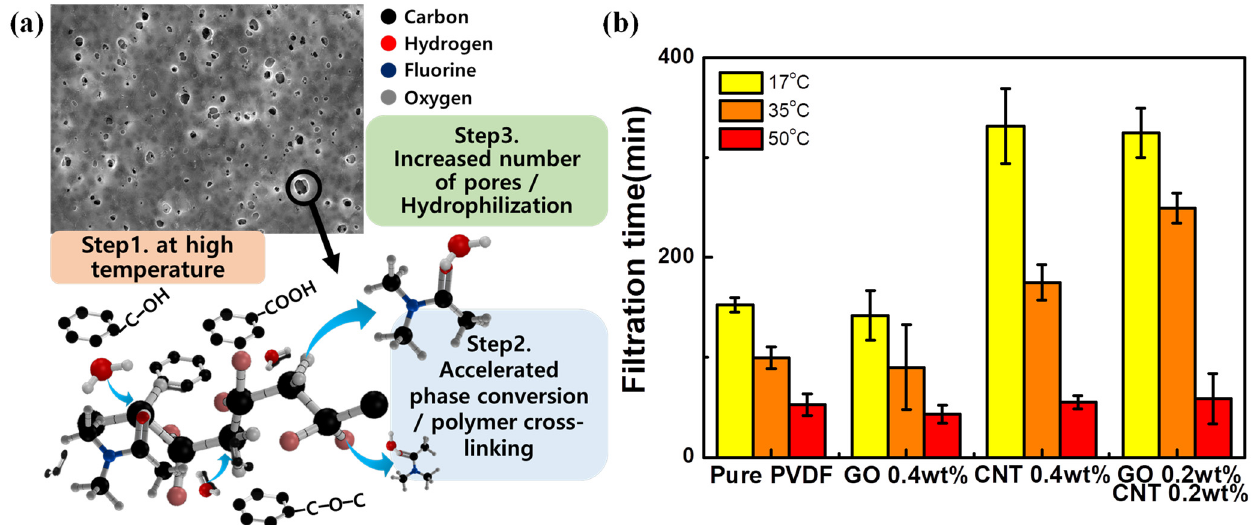
Figure 6. ( a ) The concept figure of pore modification process of carbon material-based PVDF membrane. ( b ) Filtration time of each PVDF membrane.